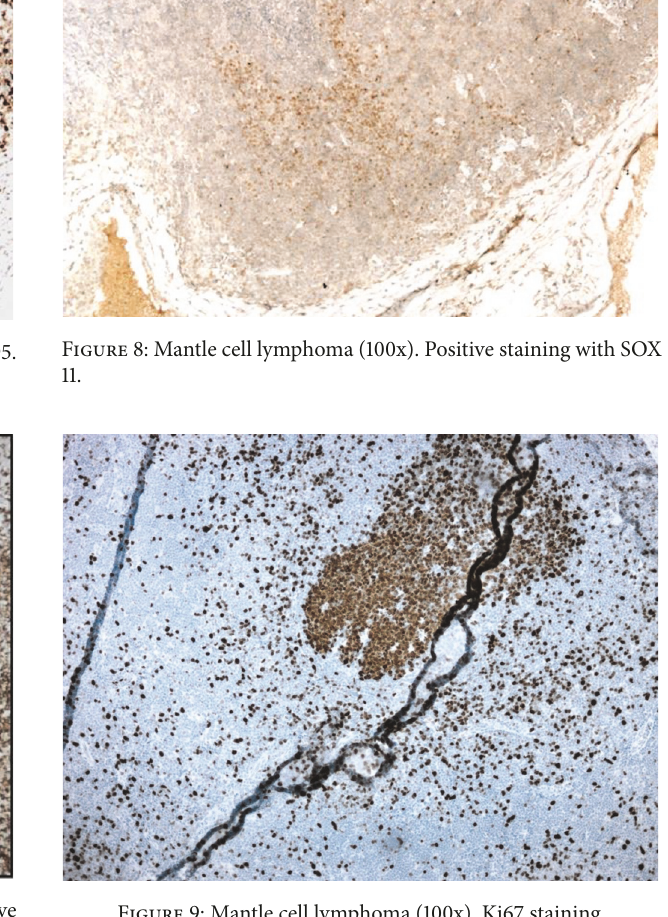
Figure 9: Mantle cell lymphoma (100x). Ki67